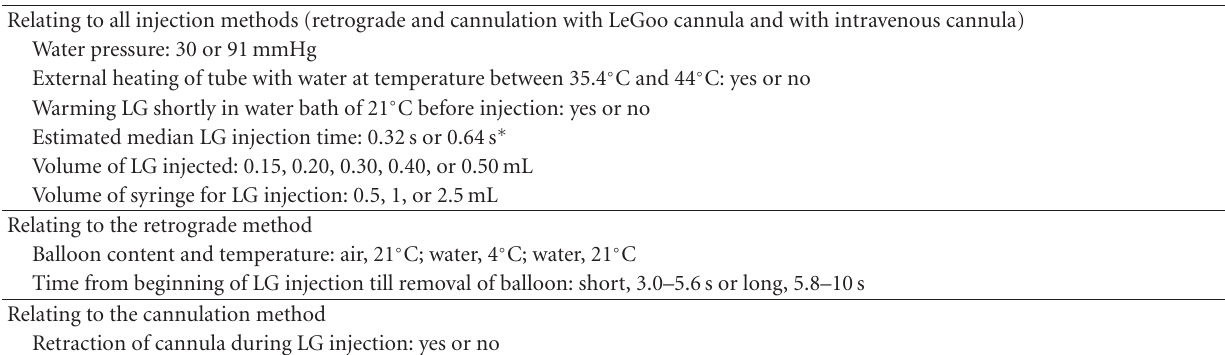
Table 1: Experimental